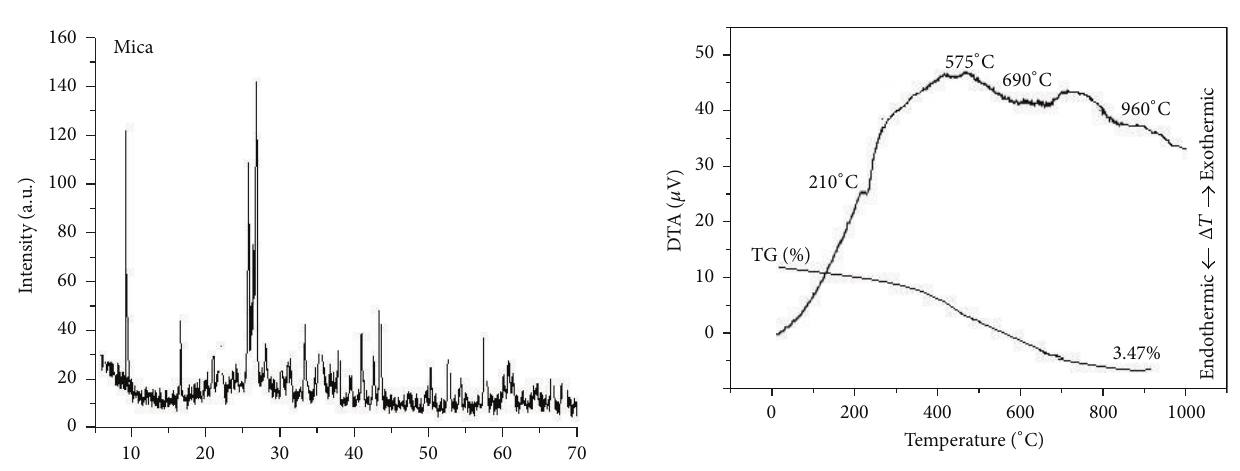
Figure 3: DTA and TGA results of the initial mica sample, series M 0 .